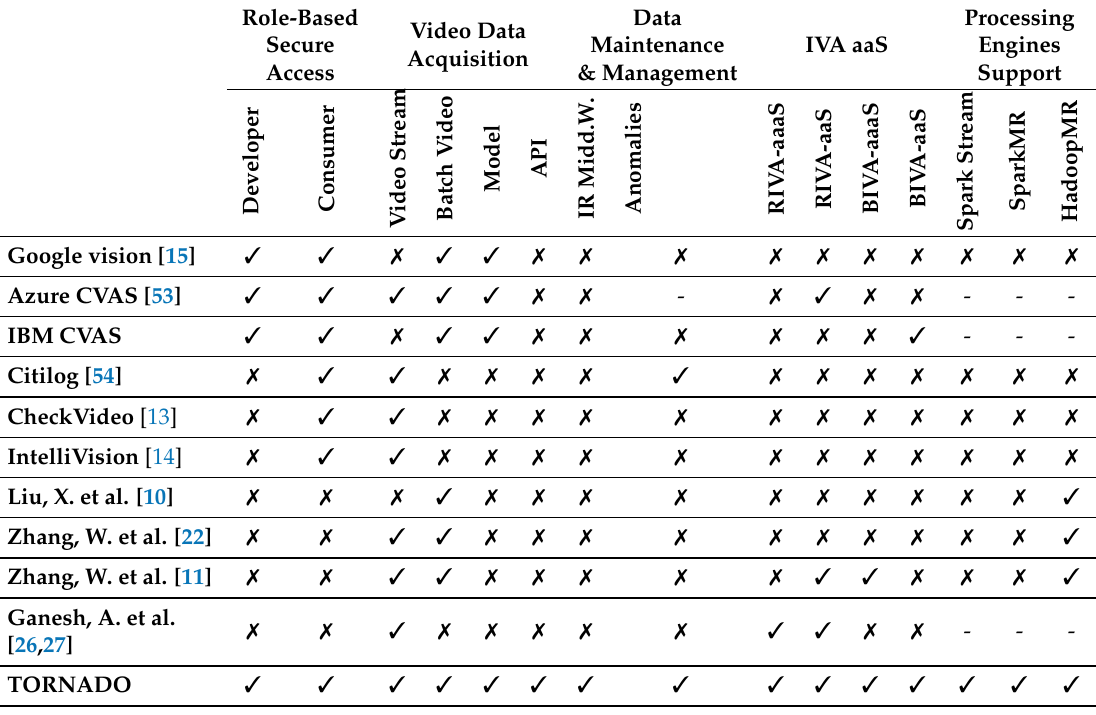
Table 4. Feature-wise comparison with state-of-the-art Cloud-based Video Analytics System